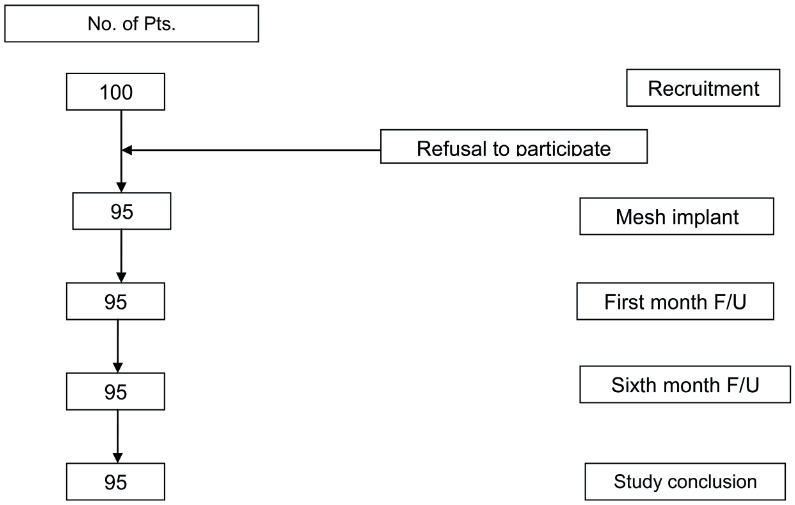
Patient flow-chart